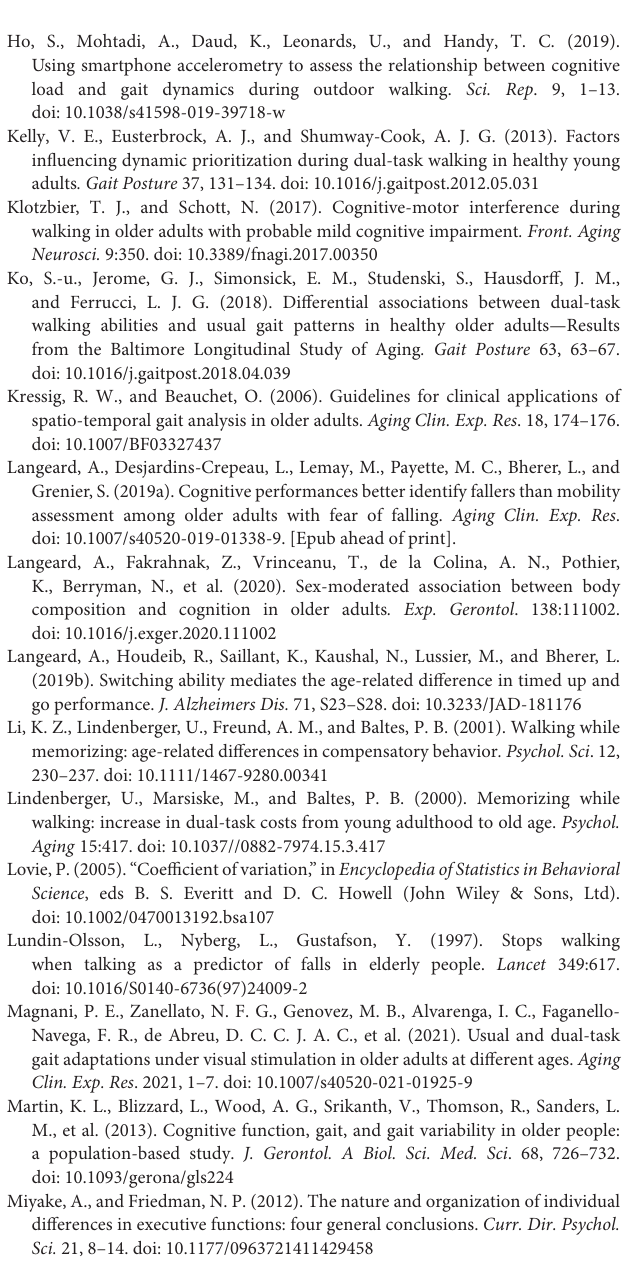
Supplementary Figure 1 | Representation of the repartition of the percentage of participants according to the number of correct answer to the single-task oral trail making test part-A (ST OTMT-A), to the dual-task oral trail making test part-A (DT OTMT-A), to the single-task oral trail making test part-B (ST OTMT-B), and to the dual-task oral trail making test part-B (DT